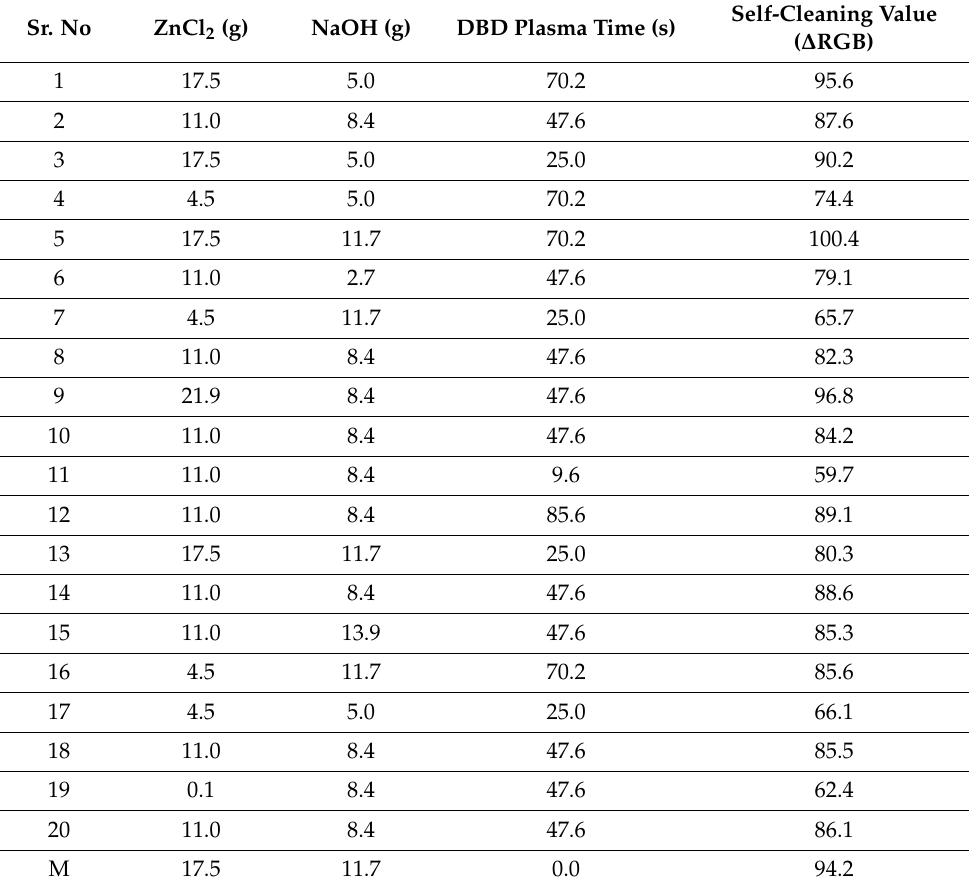
Table 1. Actual values of input parameters along with the experimental results of all CCD-based experiments and a control